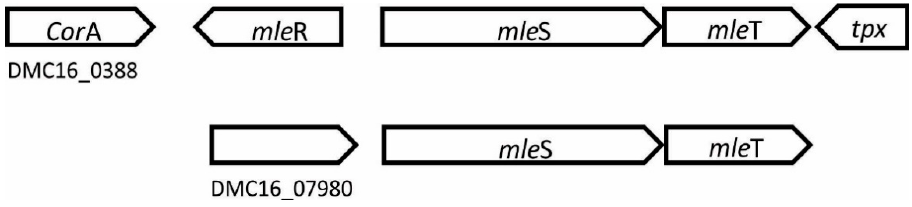
Figure 4. Schematic representation of the mle gene clusters in Lcb. paracasei UNQLpc